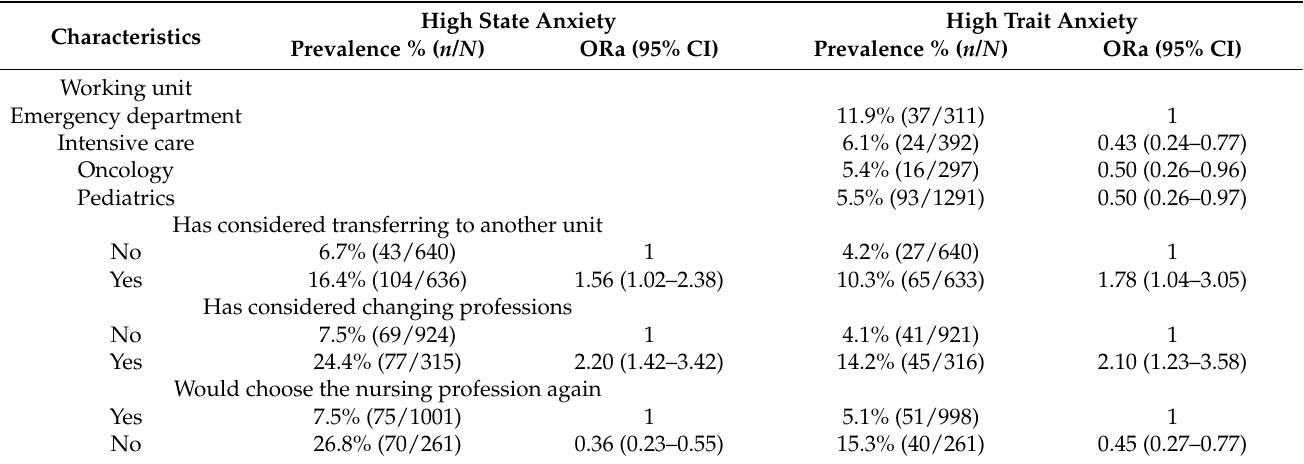
Table 4. Factors associated with anxiety, according to State-Trait Anxiety Inventory